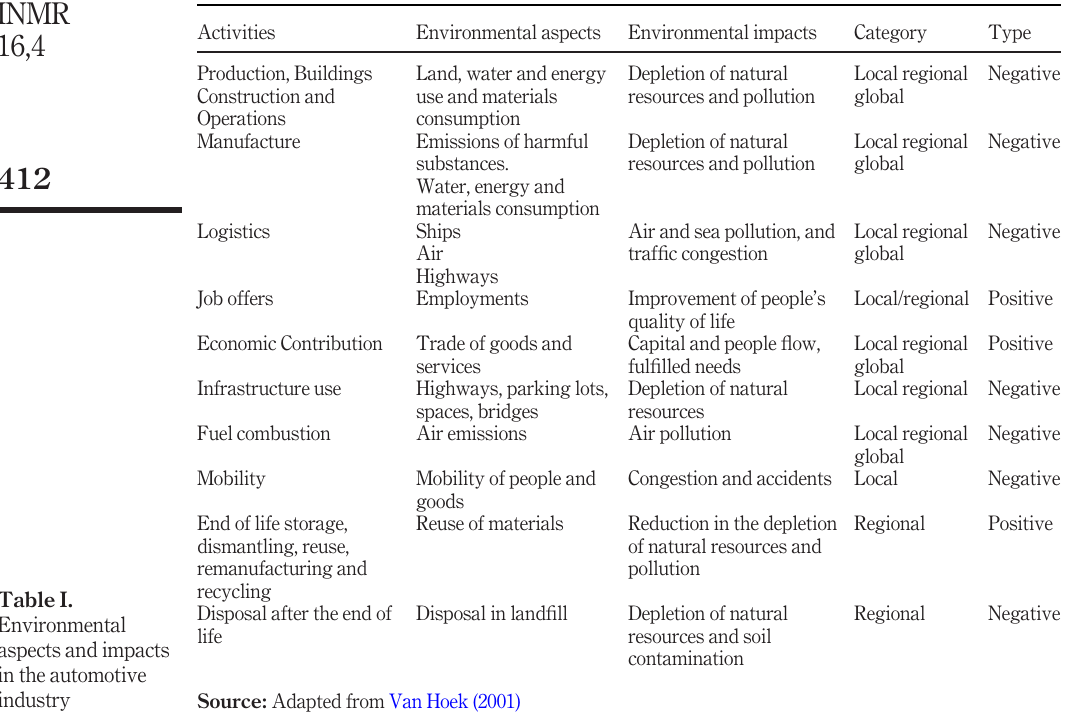
Table I. Environmental aspects and impacts in the automotive